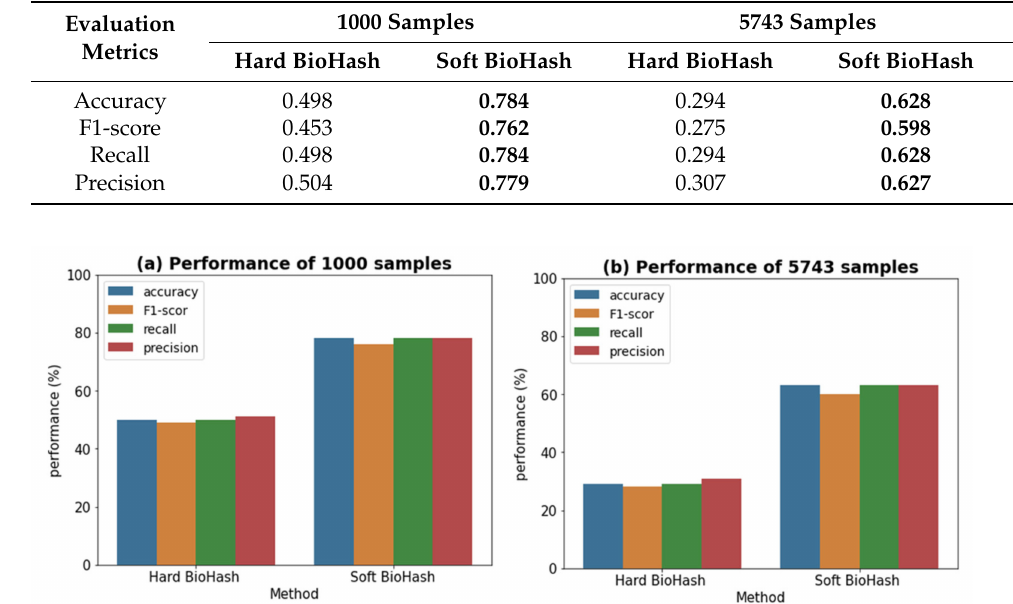
Figure 8. Performance comparison of Hard and Soft BioHash methods with various standard evaluation metrics. ( a ) Represents performance with 1000 samples; ( b ) represents the performance with 5743